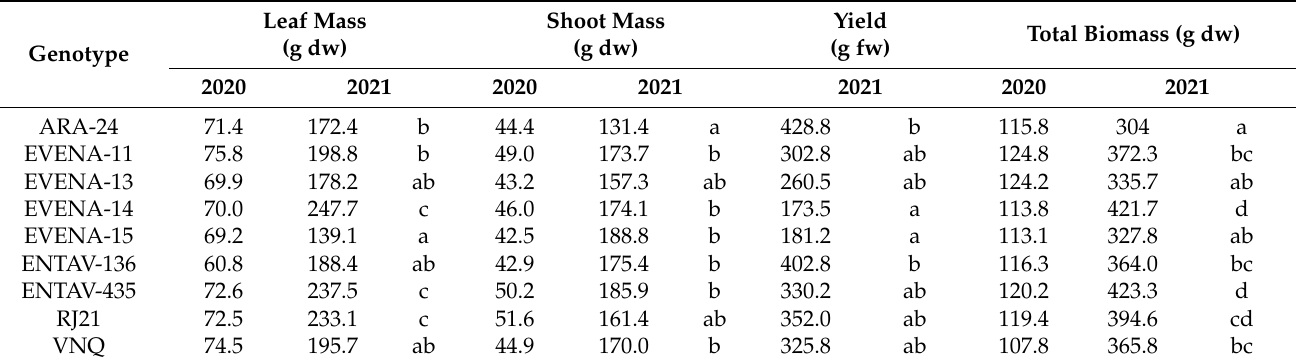
Table 4. Grapevine biomass for each of the 9 “Grenache” genotypes at the end of the experiment in 2020 and 2021, in Mallorca,